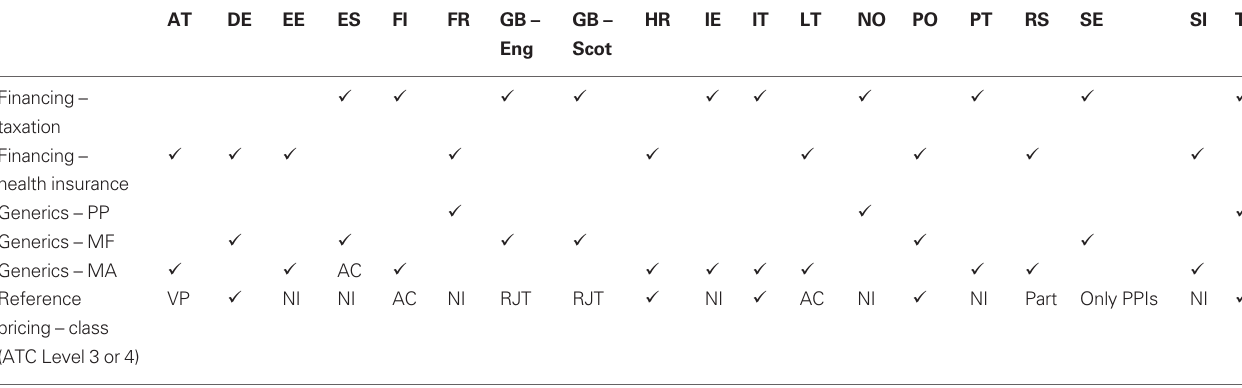
Table 1 | Characteristics of the European countries in 2008 (using published definitions for generic pricing). AT DE EE ES FI